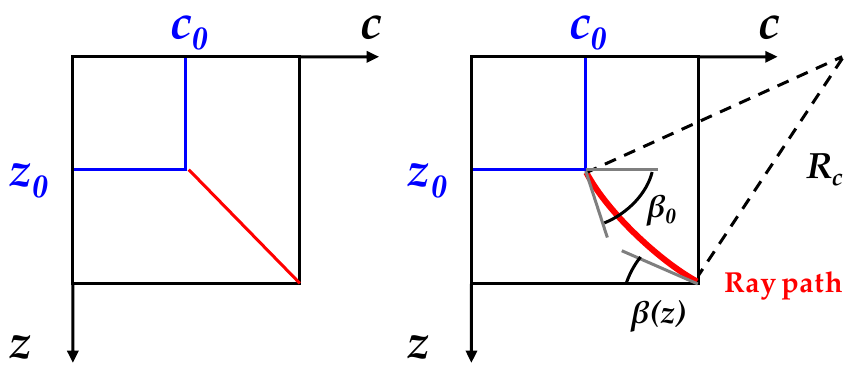
Figure 2. Trend of the rays when the speed varies linearly with the depth.